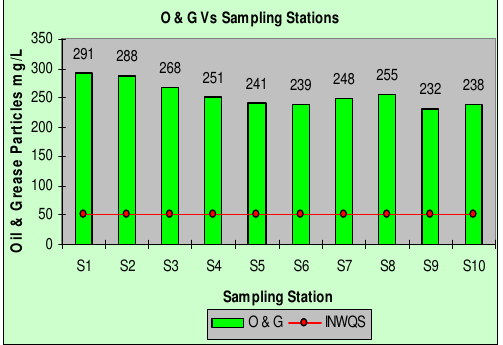
Figure 6. Oil & Grease Particles vs. Sampling